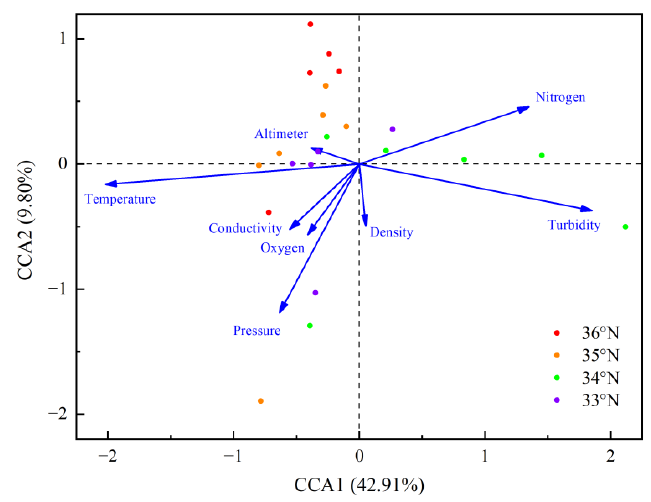
Figure 10. Canonical correspondence analysis of bacterial communities at the OTU level in the Yellow Sea. Yellow Sea.